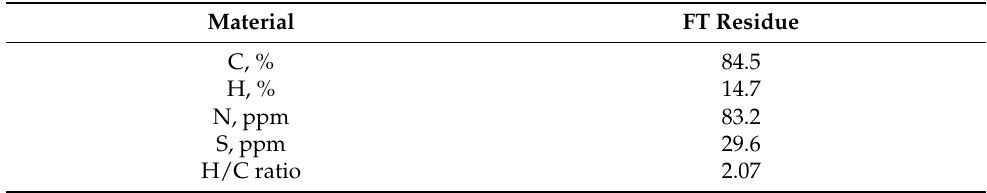
Table 3. Elemental C, H, N, S percent analyses for FTS paraffins.